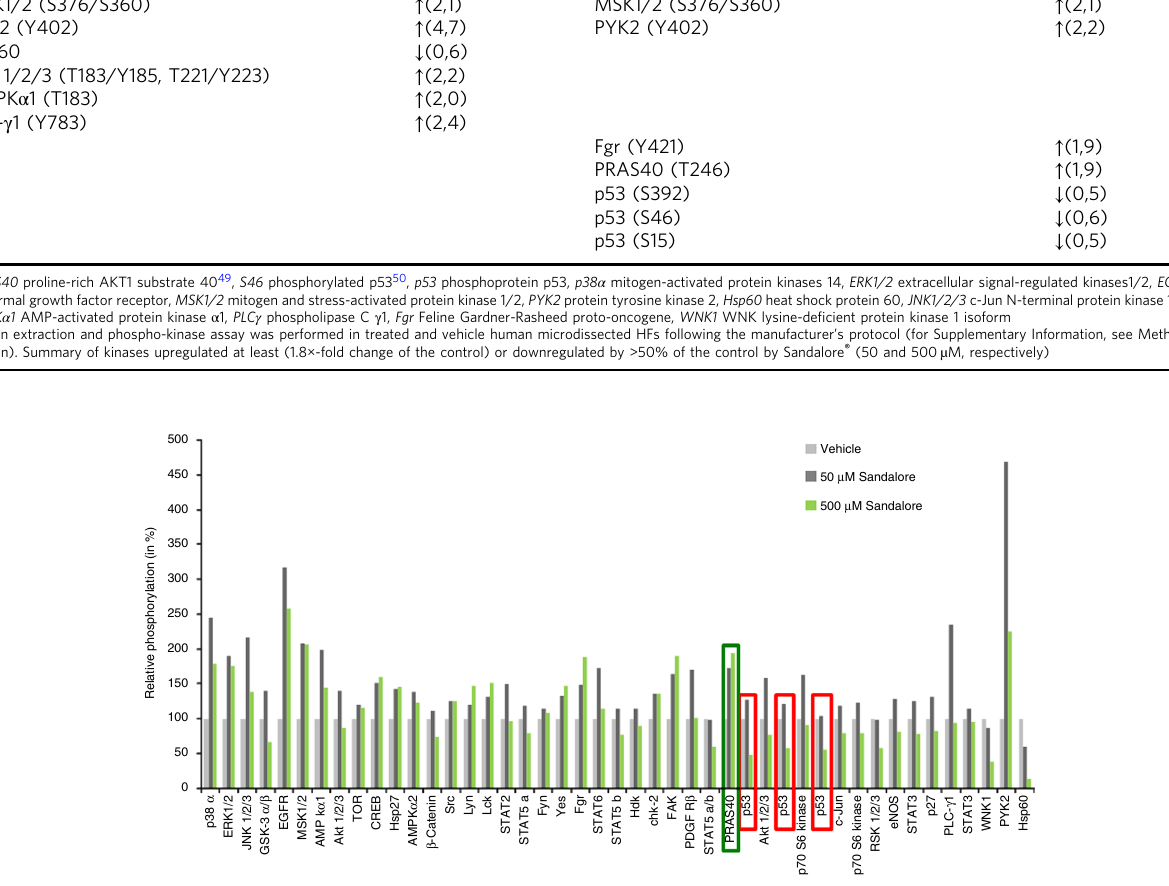
Type of regulation Proteins regulated under 500 µ M Sandalore stimulation